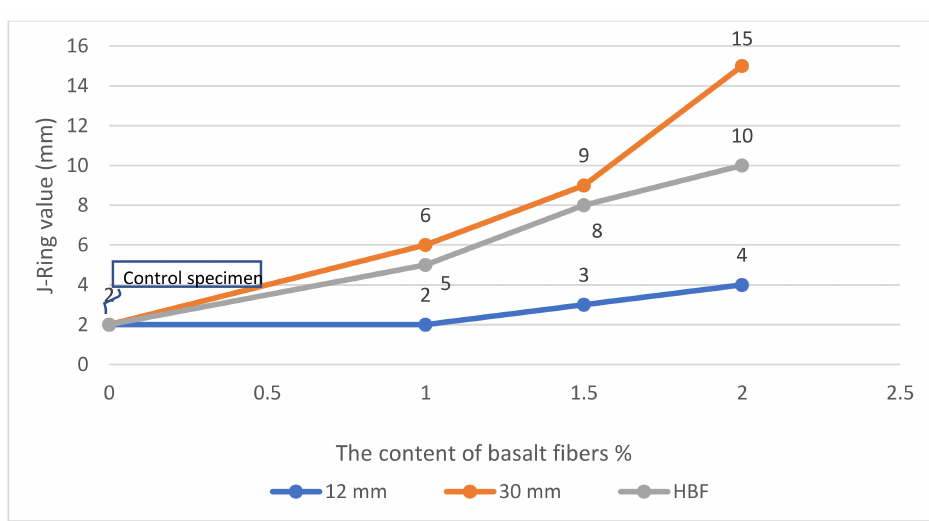
Figure 10. Variation of the J-ring value with BFs fibre content for different fibre